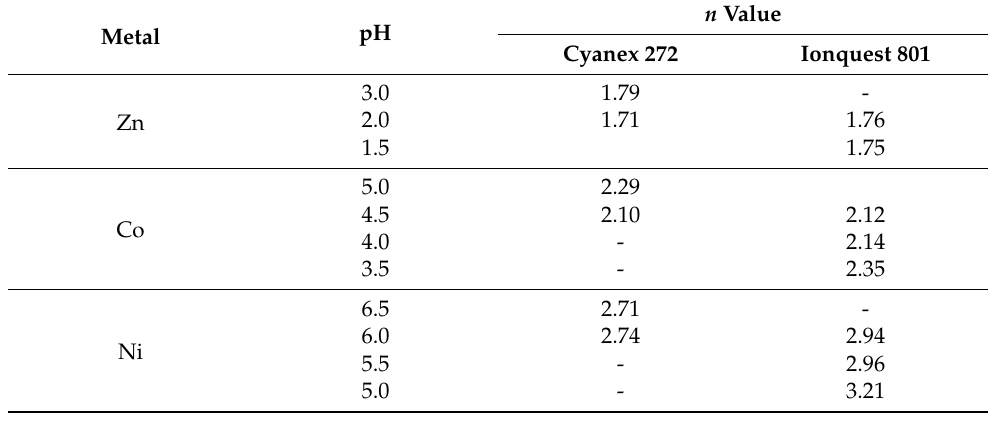
Figure 3. The relationship of Log D ( M ) against Log [dimer Ionquest 801] f . ( a ) Log D(Zn)-Log[dimer Ionquest 801], ( b ) Log Table 3. Slopes of straight lines in Figures 2 and 3, and the corresponding n values in Equation (3).